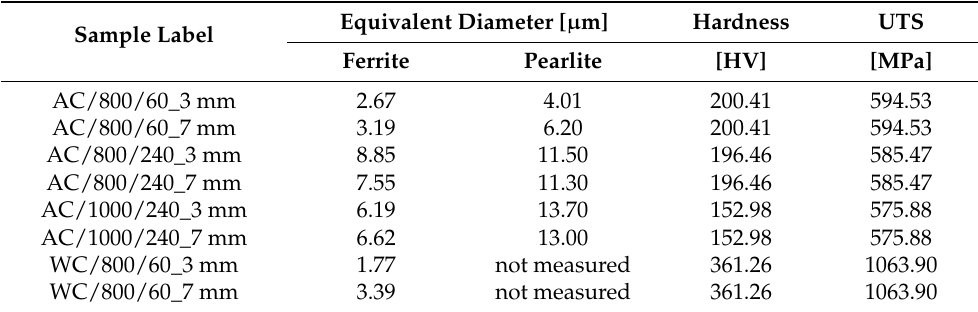
Table 10. Results of measurements of the mean equivalent diameter of ferrite and pearlite grains, hardness, and strength of respective series of